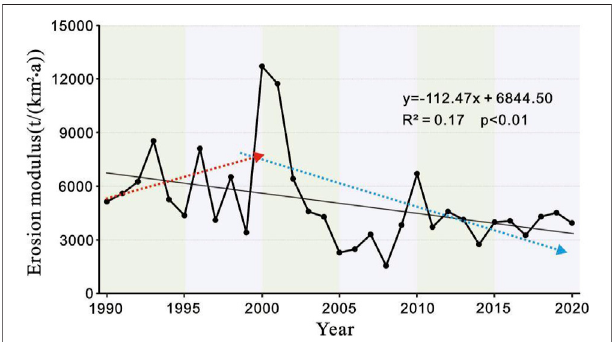
FIGURE 6 | Long time-series of the soil – wind erosion modulus from 1990 to 2020.